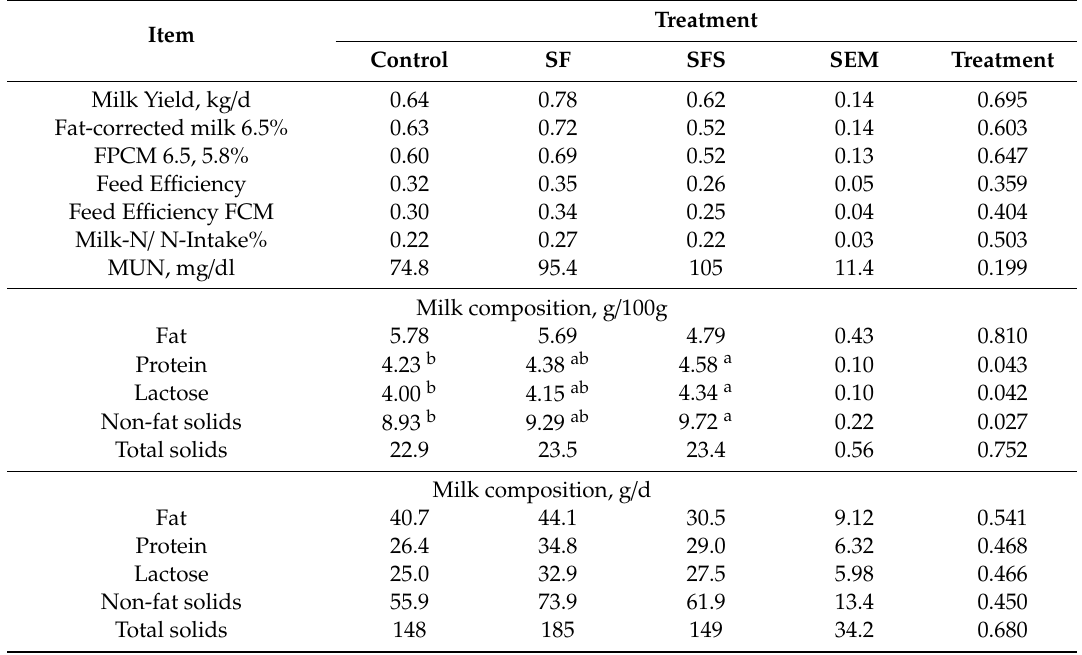
Table 5. Milk yield and milk composition from dairy sheep fed control, sunflower seeds (SF), and sunflower seeds silage (SFS)